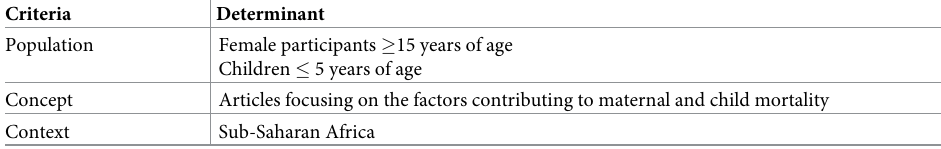
Table 1. PCC Framework for defining the eligibility of the research